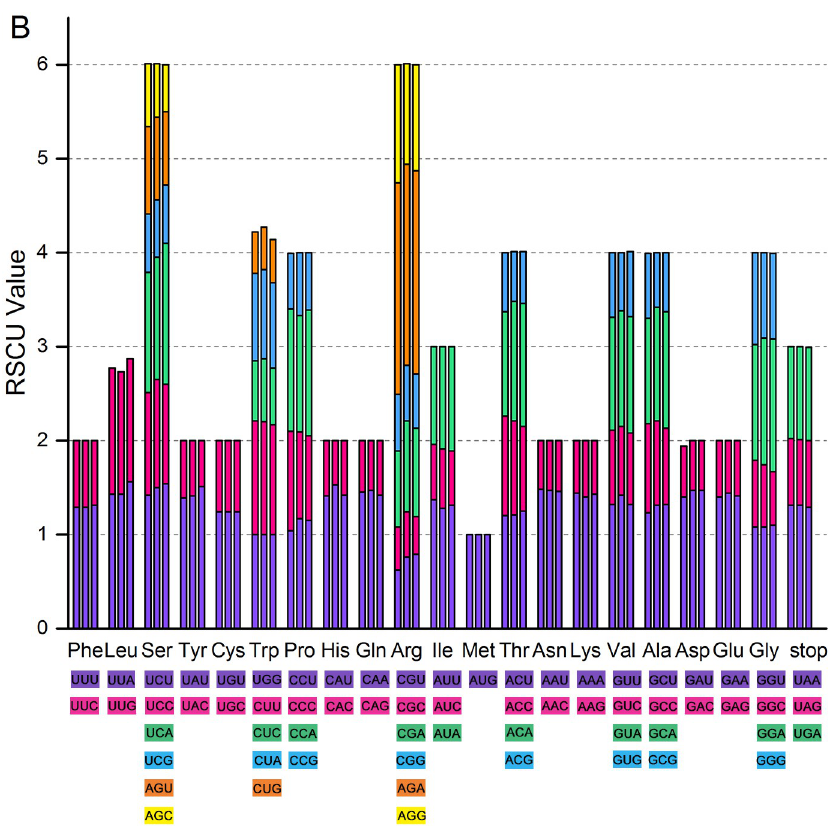
Fig 6. Codon content of 20 amino acids and stop codons in all protein-coding genes of chloroplast genomes of T . mongolica , Z . xanthoxylon , and Z . fabago